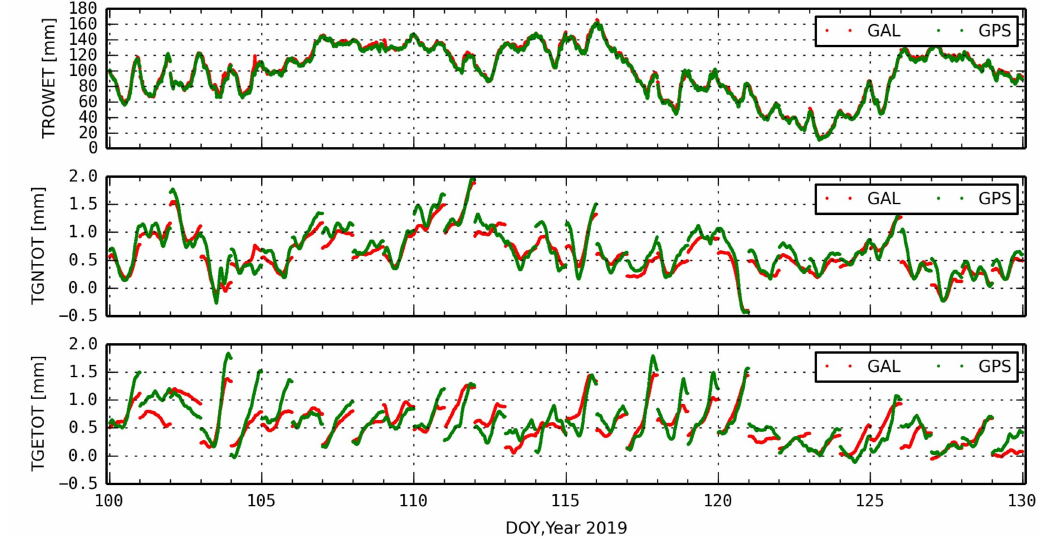
Figure 10. Time series of ZWD (top), North component (middle), and East component (bottom) of the troposphere horizontal gradient obtained with GPS and Galileo IF solutions at the AREG station.